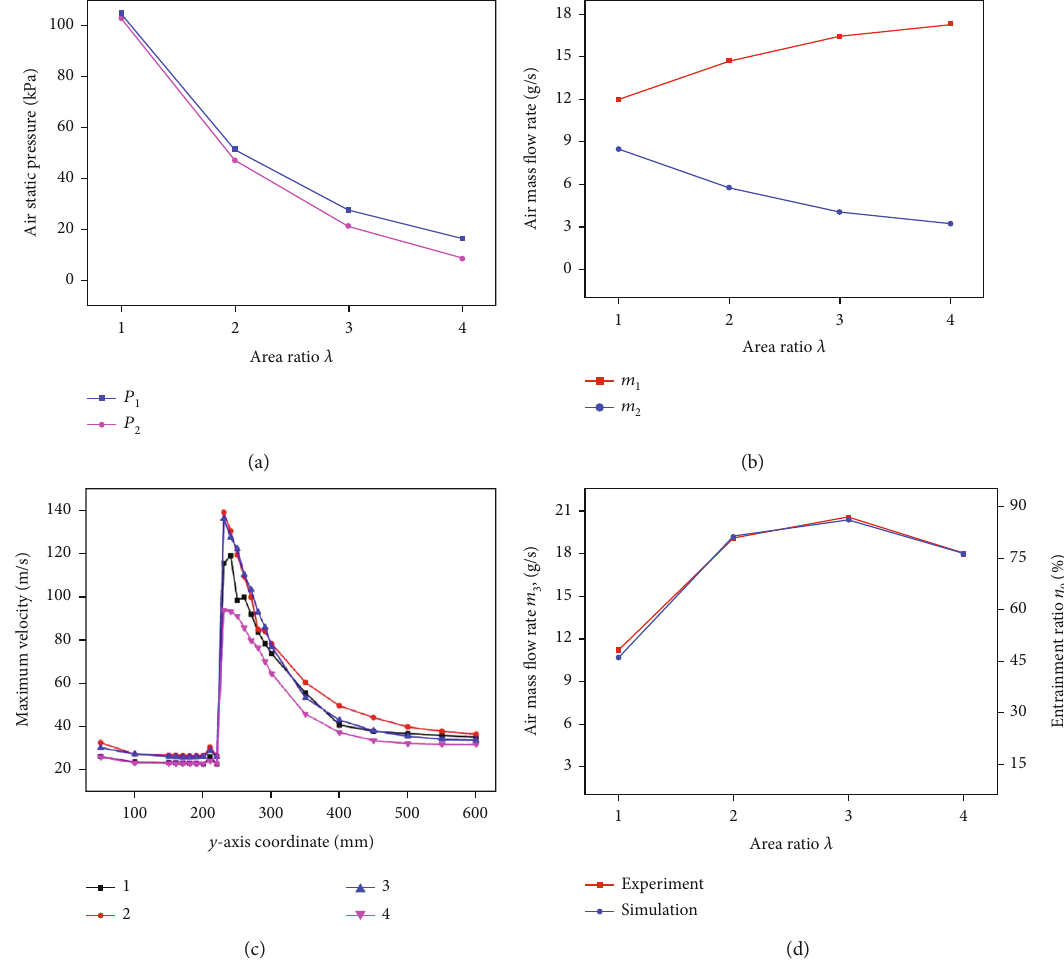
Figure 14: Relationship between area ratio and entrainment performance of drill bit with fl ushing nozzles: (a) static pressure; (b) air mass fl ow rate m m 1 and 2 ; (c) maximum velocity; (d) entrainment